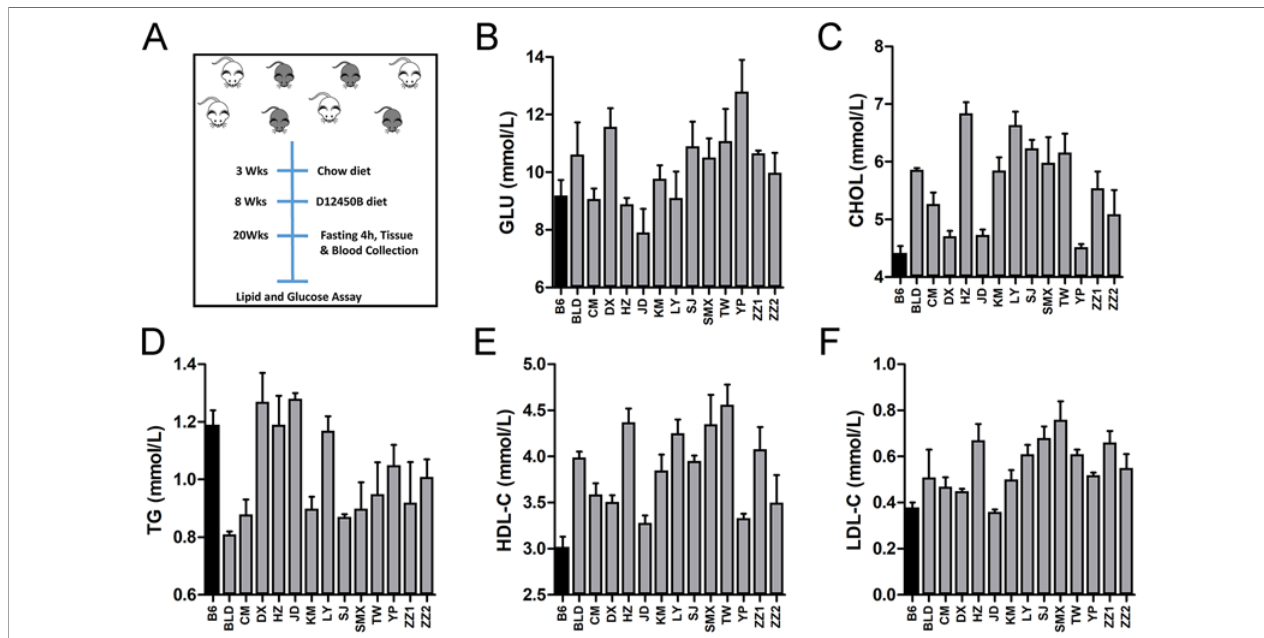
FIGURE 2 | Phenotype distributions across C1SLs and B6. (A) Schematic of traits collection (B – F) Bar plot of plasma lipid and fasting glucose levels across C1SLs and B6 (mean + standard errors). Each bar represents one strain, and the black corresponds to the recipient strain